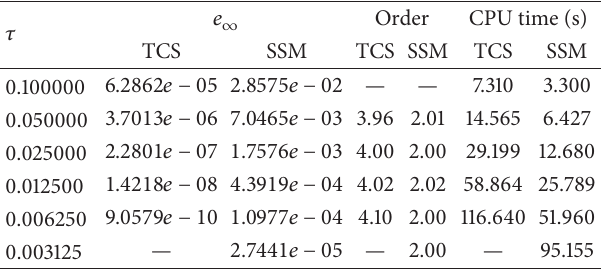
Table 1: (Example 1) comparison of errors, orders, and CPU times for different schemes with ℎ = 0.0156 at 𝑡 = 0.5 .